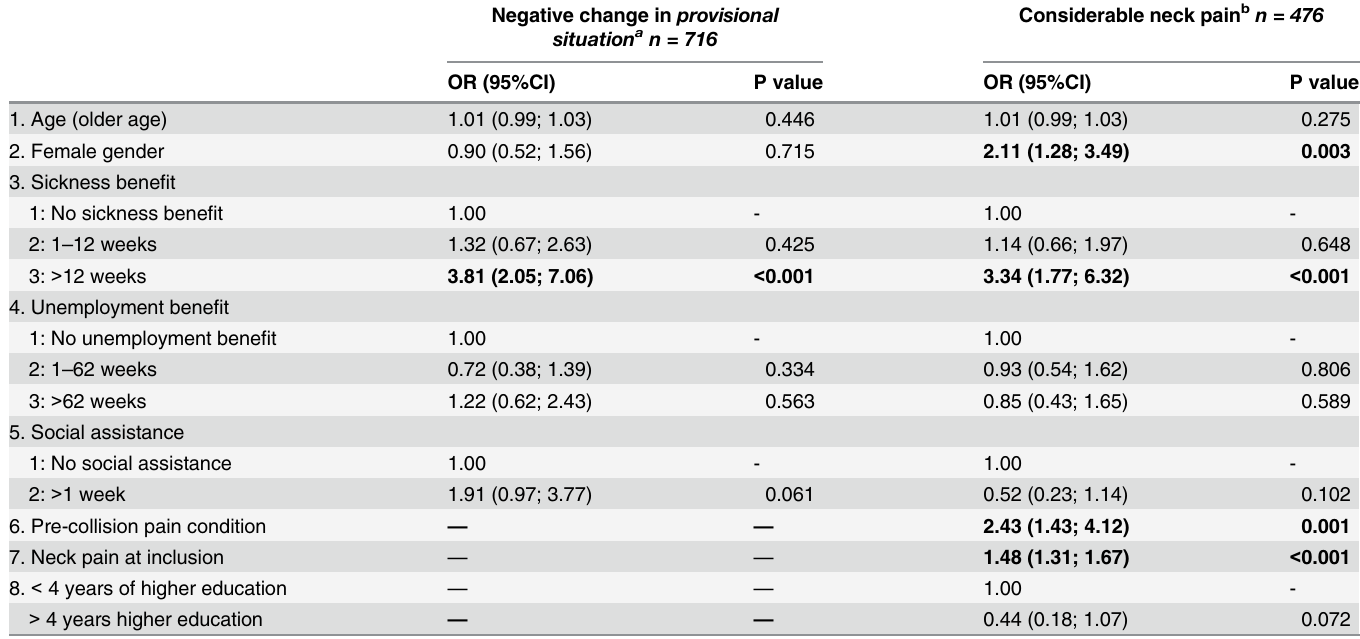
Table 5. Multiple logistic models on the WAD cohort with odds ratios of potential predictive variables on provisional situation and considerable neck pain at 12-month